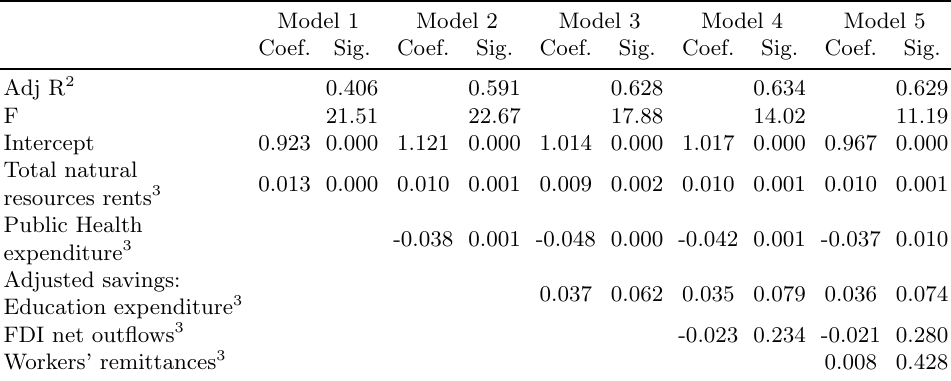
Table 3: Linear regression to explain the Zipf curve elasticity by country Model 1 Model 2 Model 3 Model